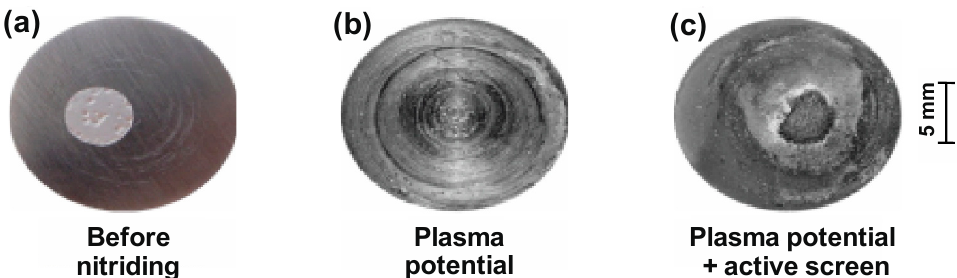
Figure 9. Image of nitrided 316L steel substrate, after potentiodynamic tests: ( a ) before nitriding, ( b ) plasma potential, ( c ) plasma potential + active screen.